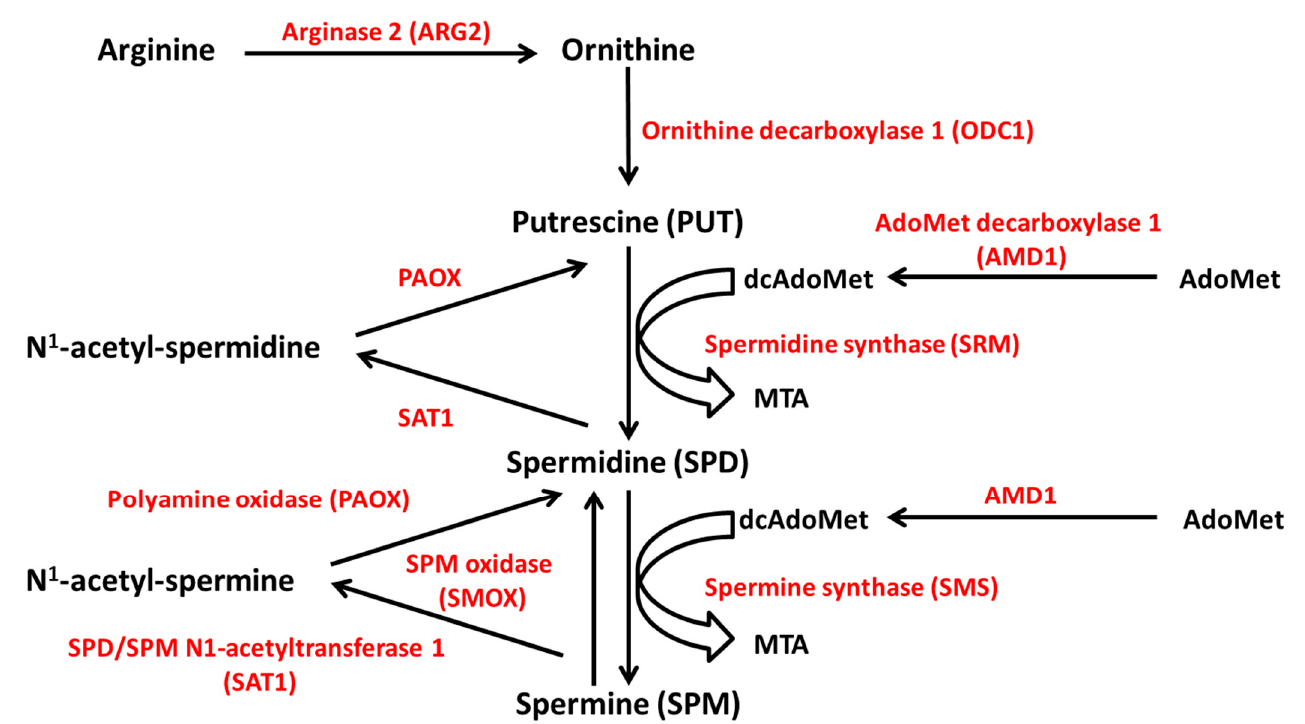
Figure 6. Polyamine metabolism. Polyamines are synthesized from ornithine, which derives from arginine through the reaction of ARG2. Ornithine is converted to putrescine by ODC1. Spermidine and spermine derive from putrescine by successive attachment of two propylamine groups by the action of SRM and SMS, respectively. The propylamine group donor is the decarboxylated S-adenosylmethionine (dcAdoMet), derived from S-adenosyl-methionine (AdoMet) by the action of AMD1. Polyamine catabolism depends on the acetylation of spermine and spermidine by SAT1, and the removal of the aminopropyl moiety by PAOX. Spermine can be oxidated to spermidine by SMOX. ODC1, ornithine decarboxylase 1; SRM, spermidine synthase; SMS, spermine synthase; AMD1, AdoMet decarboxylase 1; SAT1, SPD/SPM N1-acetyltransferase 1; PAOX, polyamine oxidase; SMOX, SPM oxidase. MTA, 5 ′ -methylthioadenosine.